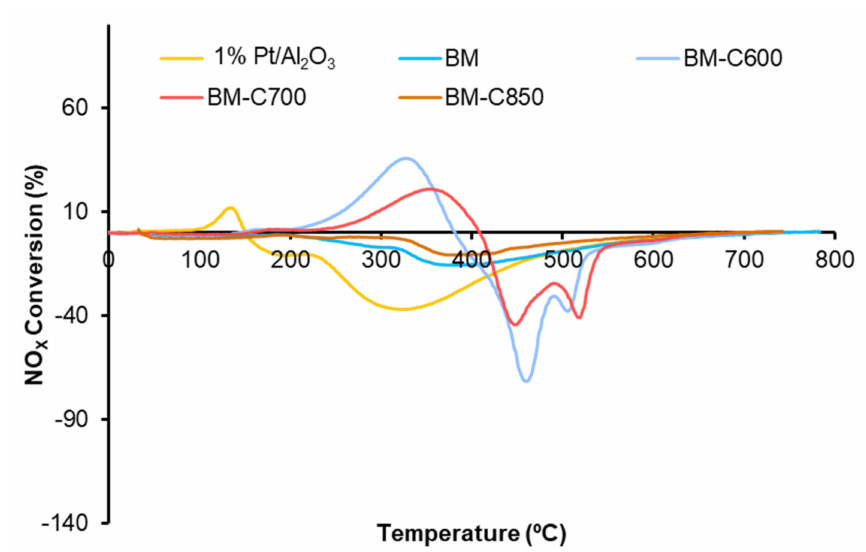
Figure 9. NO x conversion profiles in NO x -TPR conditions of BM − CX series and references (1% Pt/Al 2 O 3 and BM).